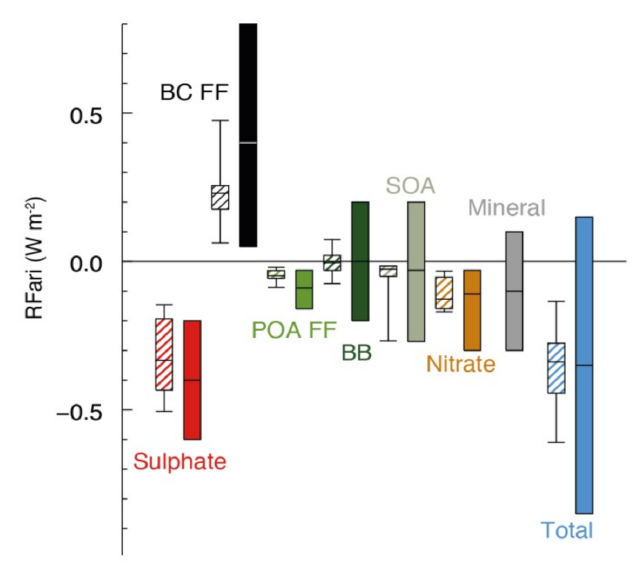
Figure 2. Annual mean top of the atmosphere radiative forcing due to aerosol–radiation interactions (RFari, in W m –2 ) due to different anthropogenic aerosol types, for the 1750–2010 period. Hatched whisker boxes show median (line), 5th to 95th percentile ranges (box) and min/max values (whiskers) from AeroCom II models [46] corrected for the 1750–2010 period. Solid colored boxes show the AR5 best estimates and 90% uncertainty ranges. BC FF is for black carbon from fossil fuel and biofuel, POA FF is for primary organic aerosol from fossil fuel and biofuel, BB is for biomass burning aerosols, and SOA is for secondary organic aerosols—reproduced with permission from ref.